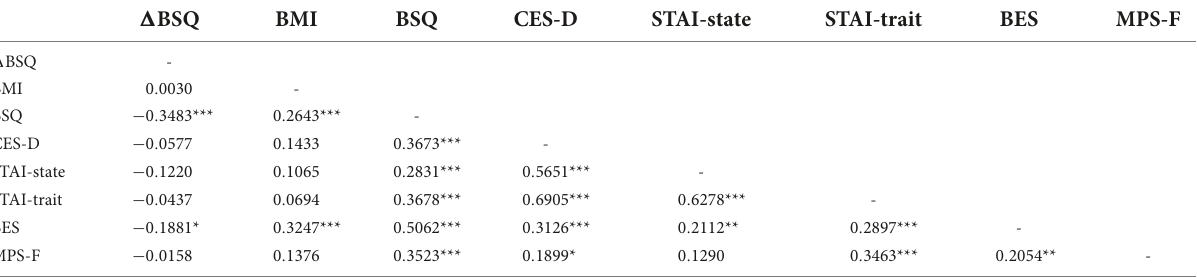
TABLE 2 Correlations between (cid:49) BSQ and baseline clinical variables.